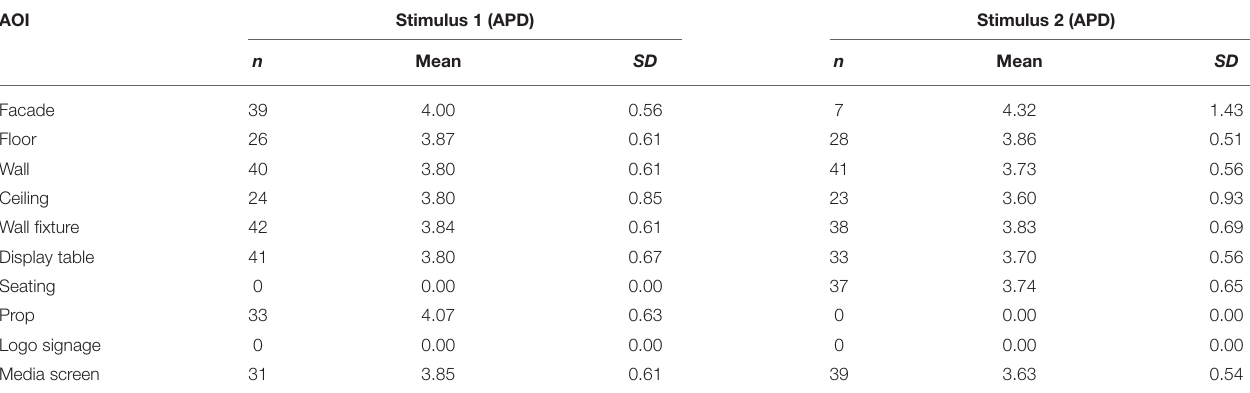
TABLE 3 | Means and SD s for average pupil diameter per AOI.